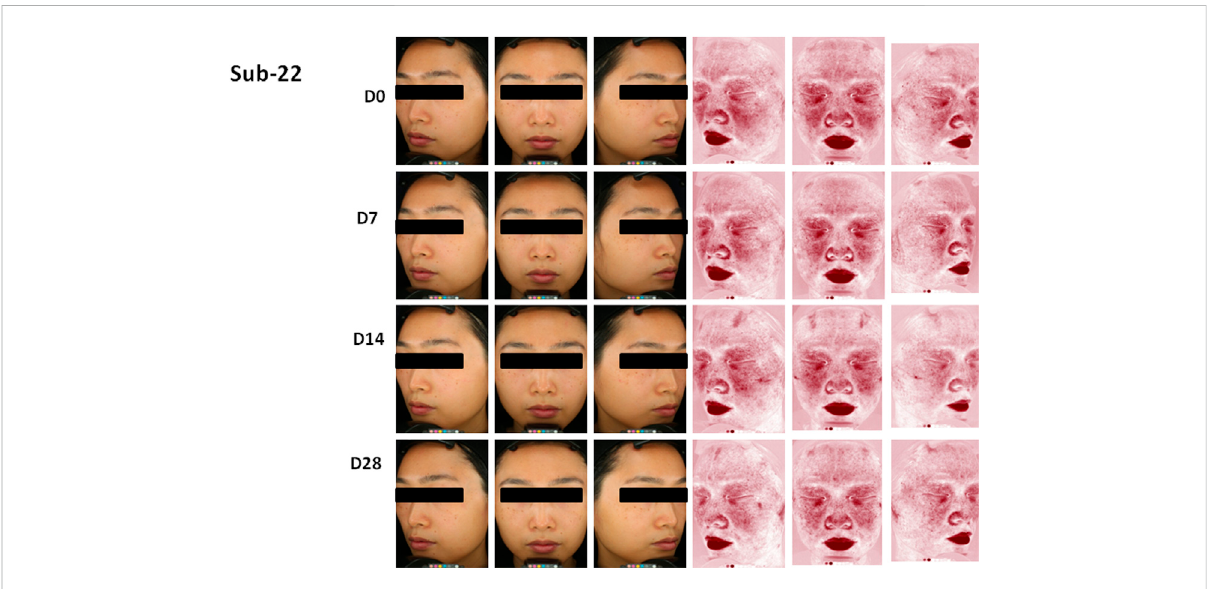
FIGURE 6 Photographs of volunteer #22 with VISTA ” system at 0 day (DO), 7 days (D7), 14 days (D14) and 28 days (D28), Improvement of red areas could be seen at 28